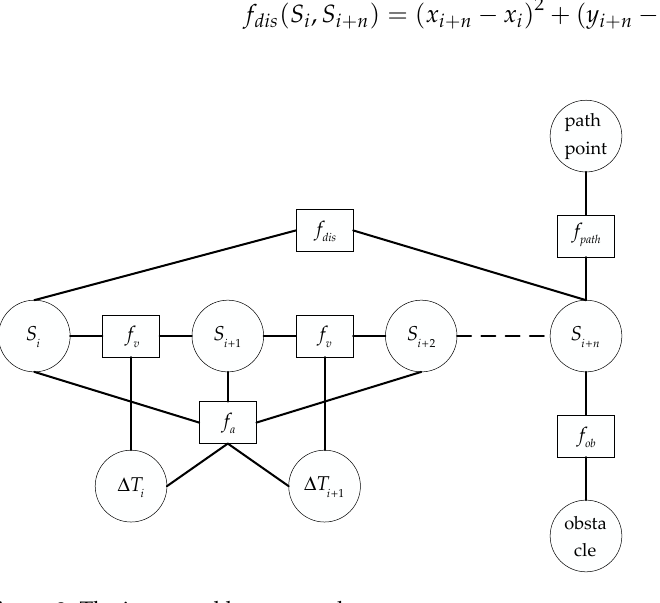
Figure 3. The improved hyper-graph.